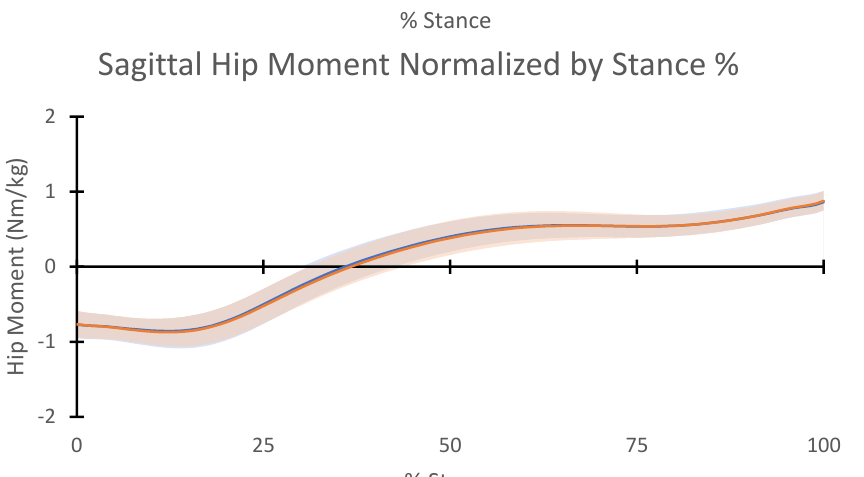
The shaded areas represent standard deviations for each part of the stance phase. The female shoe Figure 3. Comparison of the ankle, knee, and hip sagittal plane moments normalized by % stance.